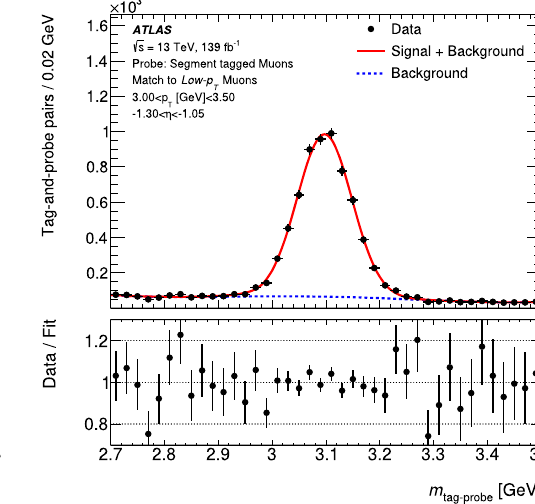
Fig. 10 Fit to the m tag − probe distribution for the selected probes (left), and the probes matched to the Low - p T selection (right), for ST probes with − 1 . 30 < η < − 1 . 05 and 3 . 0 < p T < 3 . 5 GeV. The blue line indicates the fitted non-prompt muon background component, while the